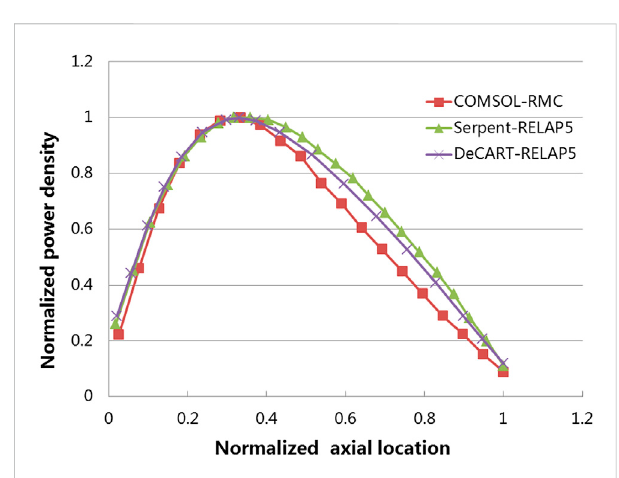
FIGURE 12 Normalized axial power density distributions